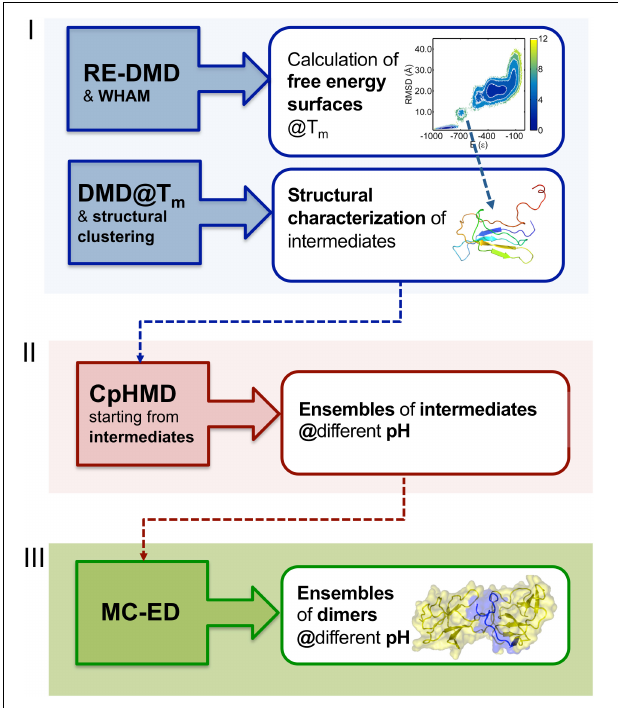
FIGURE 2 | Three-stage methodology to investigate the early phase of protein aggregation. The conformational space is explored with RE-DMD of a full atomistic G¯o model to compute equilibrium folding thermodynamics (including the melting temperature, Tm, and free energy surfaces) to detect the formation of intermediate states). Large ensembles of intermediates are collected from DMD simulations at constant temperature, and structurally characterized to select those with aggregation potential. Representative conformations are then subjected to a CpHMD protocol with explicit titration to obtain ensembles of intermediates representative of different pH conditions. The latter are finally used in a protein-protein docking protocol that creates ensembles of dimers whose statistical analysis allows determining the most likely regions and residues involved in the onset of